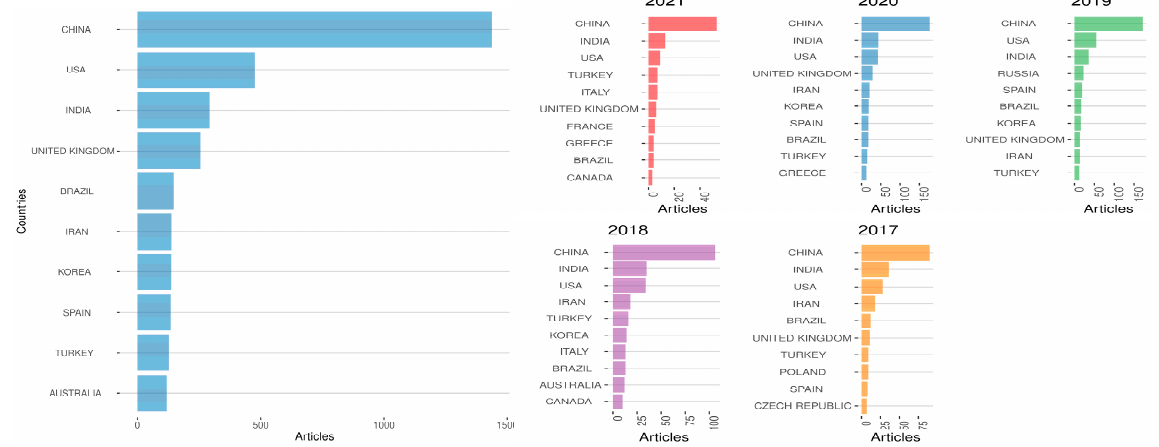
Figure 12. The most productive countries (according to authors’